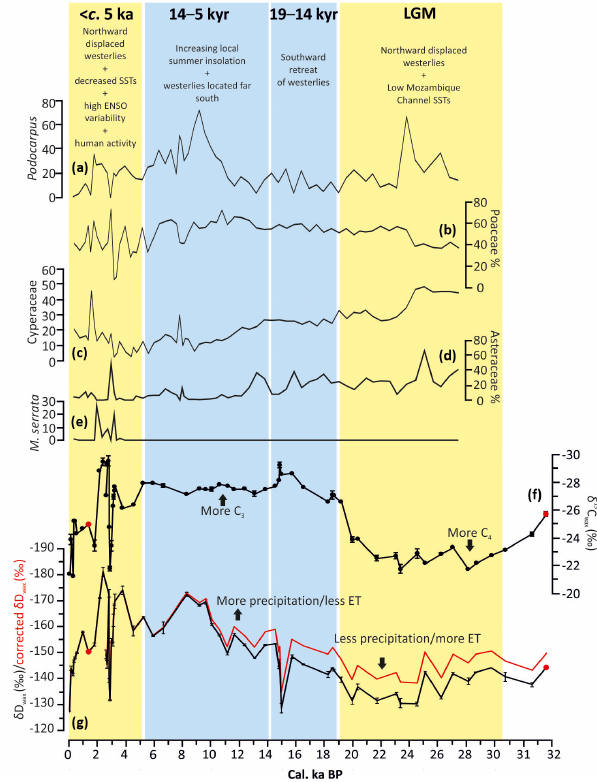
Figure 6. Summary figure highlighting the main climate phases and driving mechanisms at Mfabeni. All pollen data are from Finch and Hill (2008). Note that the new age model for pollen % data is in the Supplement (Sect. S2). (a) Podocarpus % data from Mfabeni. (b) Poaceae % data from Mfabeni. (c) Cyperaceae % data from Mfabeni. (d) Asteraceae % data from Mfabeni. (e) Morella ser- rata % data from Mfabeni. Poaceae and Cyperaceae were ex- cluded from the regional pollen sum, so their percentages are based on total pollen frequencies. Podocarpus , Asteraceae, and M. ser- rata percentages are based on regional frequencies. See Finch and Hill (2008) for more details. (f) Stable carbon isotopic composition (weighted mean) of C 29 –C 31 n -alkanes from Mfabeni. (g) Hydro- gen isotope composition (weighted mean) of C 29 –C 31 n -alkanes from Mfabeni. Red is the δ D wax corrected for ice volume changes. The two Mfabeni samples with CPI values of ca. 2 are highlighted in red. Blue shading: Mfabeni wet, orange: Mfabeni